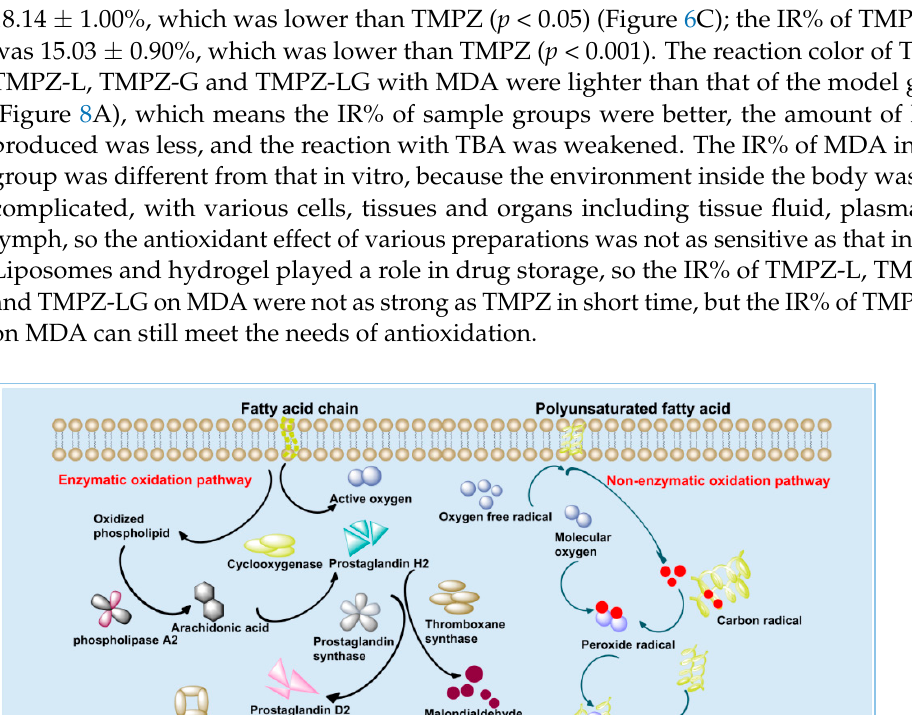
Figure 8. Color reaction diagram of MDA with TBA. ( A ) MDA in liver homogenate reacted with TBA; ( B ) MDA in low density lipoprotein reacted with TBA (where “B” is blank control group; “M” is model group). 3.8. Ex Vivo Results of antioxidation of TMPZ, TMPZ-L, TMPZ-G and TMPZ-LG: Inhibit the Production of MDA in LDL Low density lipoprotein (LDL) is a kind of lipoprotein particle that carries choles- terol into peripheral tissue cells and can be oxidized into oxidized LDL [38,39]. There are